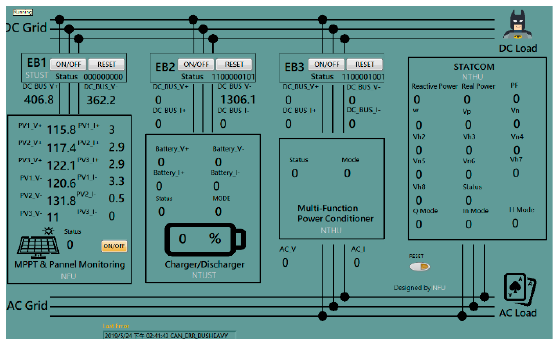
Figure 21. LabVIEW monitoring screen of with communication scan network.